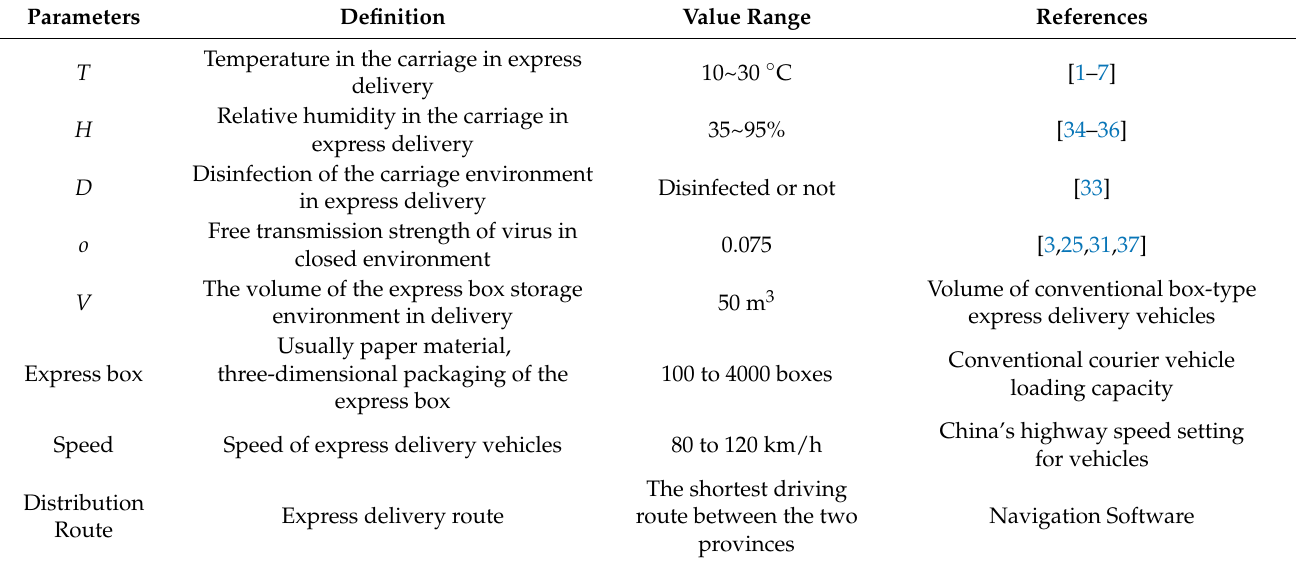
Table 1. List of important parameters used in the numerical